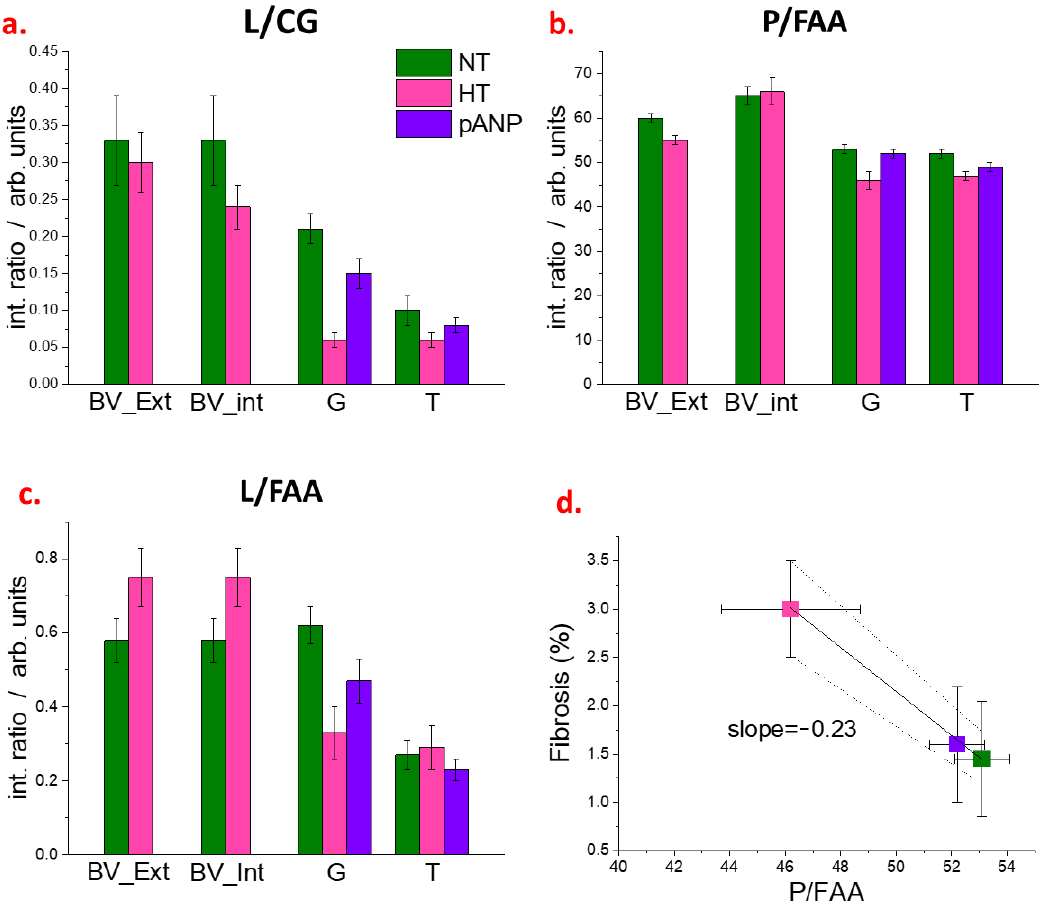
Figure 5. ( a – c ) Ratiometric analysis from FTIR spectra of NT, HT, and proANP 31 – 67 samples. Inte- grated intensities of the lipid (L, 2840 – 2860 cm −1 ), protein (P, 1485 – 1700 cm −1 ), carbohydrate/glyco- protein (C/G, 1000 – 1128 cm −1 ), and free amino acid (FAA, 1358 – 1416 cm −1 ) marker bands are used to estimate L/CG, L/FFA, and P/FAA ratios for the external (BV_Ext) and internal (BV_Int) regions of blood vessels, for glomeruli (G) and tubules (T). ( d ), Linear regression for the renal fibrosis as assessed by Masson’s trichrome staining versus glomeruli P/FAA. The dotted lines indicate the 95% confidence range of the best-fit line. Legend: NT, normotensive; HT, hypertensive; pANP, proANP 31 – 67 -treated.